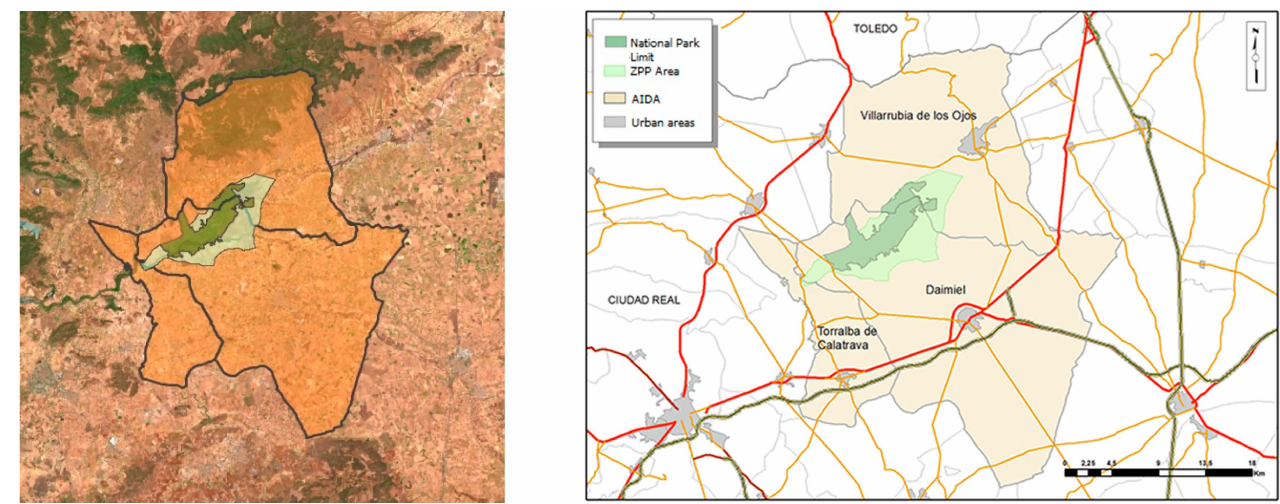
Figure 8. Area of influence of diffuse anthropization in the Tablas de Daimiel National Park.